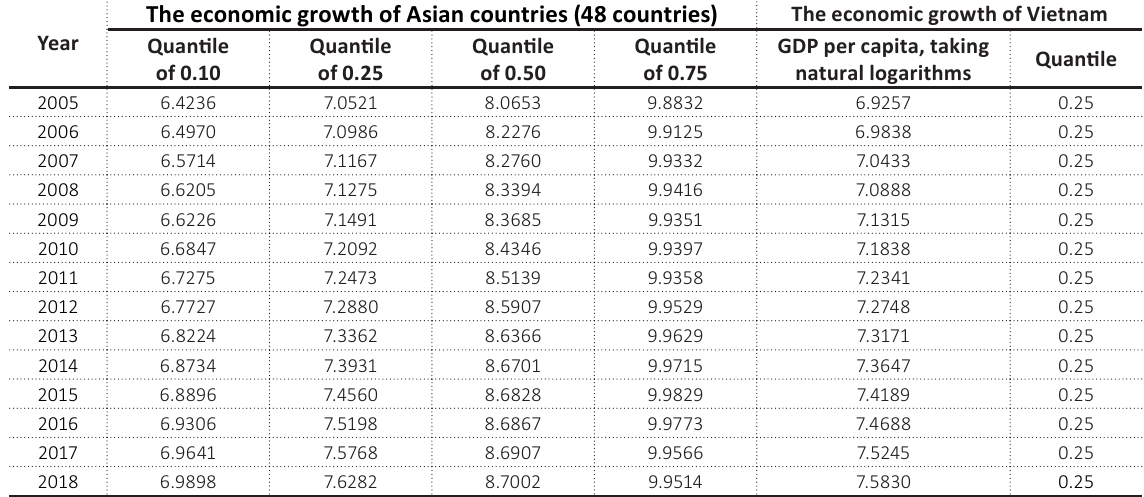
Table 6. CPIA index of Vietnam during the period 2005–2018